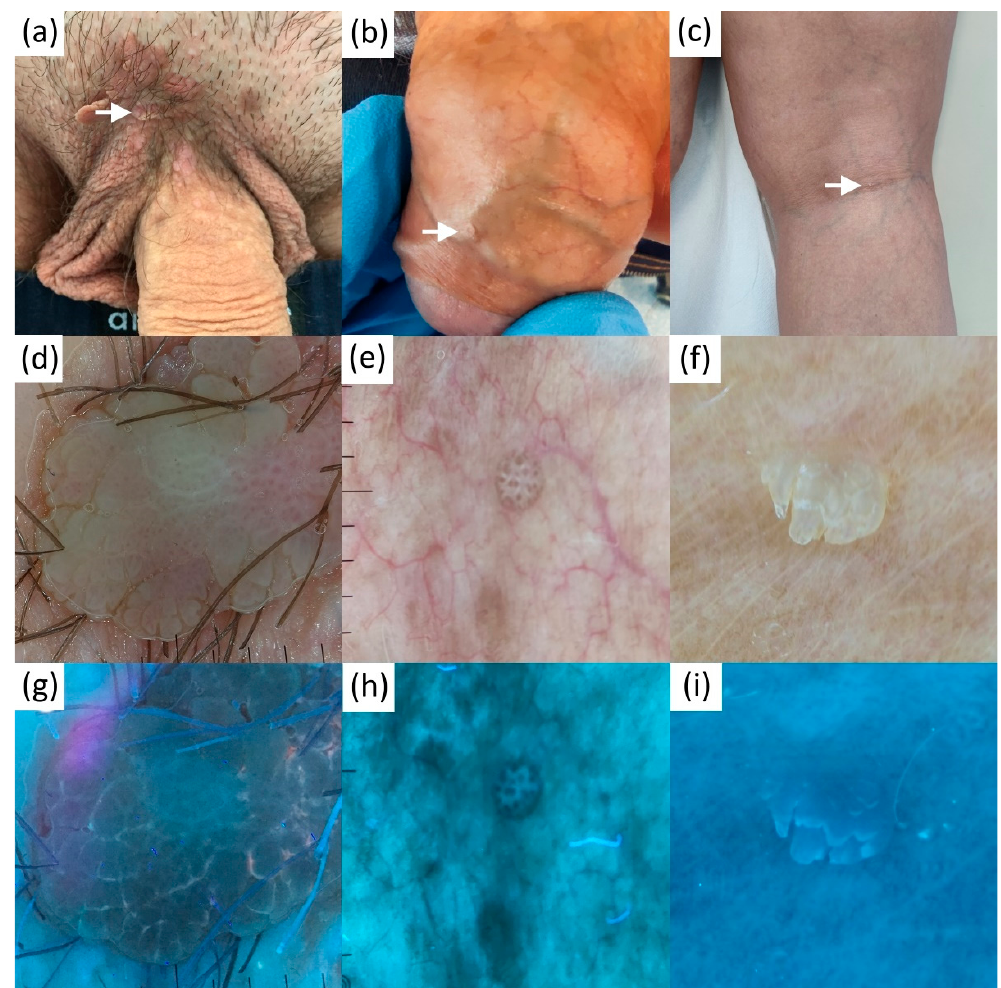
Figure 5. Clinical ( a – c ), contact-polarized ( d – f ), and ultraviolet-induced fluorescence ( g – i ) dermato- scopic images of 3 patients with genital human papillomavirus warts. Note that the violet glow in the top left portion of the photo ( g ) is an artifact. PPP, seen as whitish clods with centered glomerular vessels in polarized dermatoscopy, were neutral in UVFD (Figure 6).